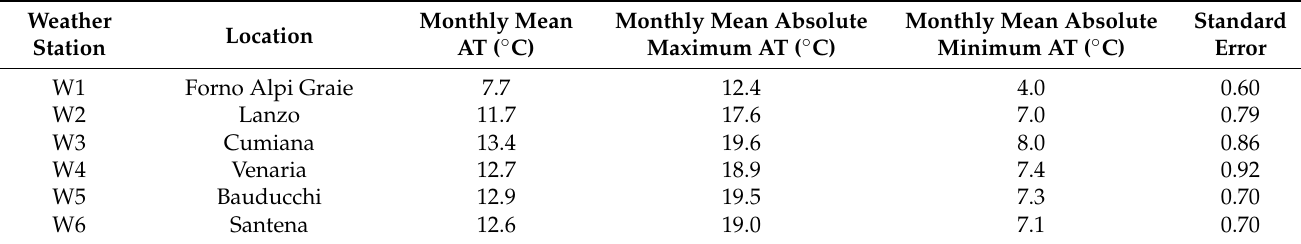
Table 2. Summary of statistical data for AT (mean, mean absolute maximum, mean absolute minimum and standard error) for the observed weather